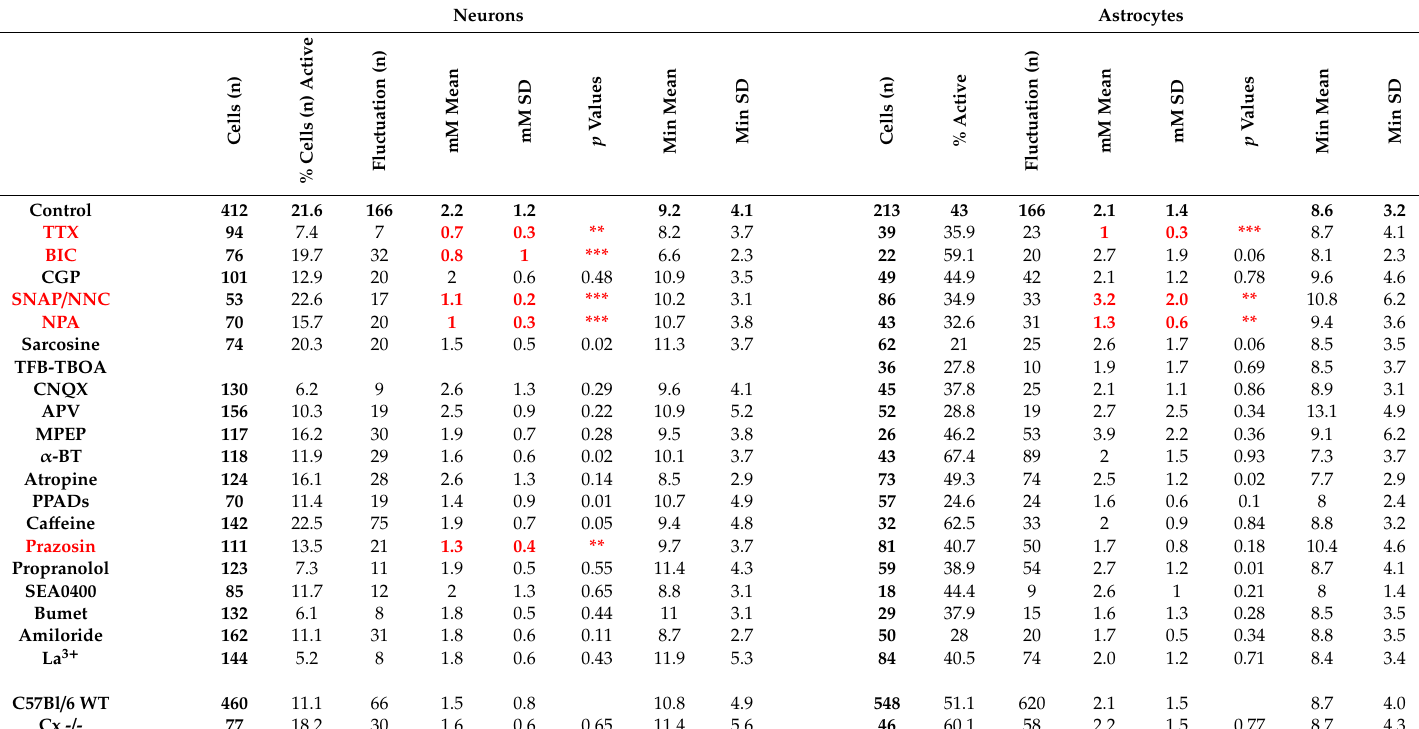
Table 2. Number of neurons (left) and astrocytes (right) measured, the % of these showing activity, the total number of fluctuations analyzed under each condition and the mean and standard deviation for the amplitude (mM) and duration (minutes) for analyzed